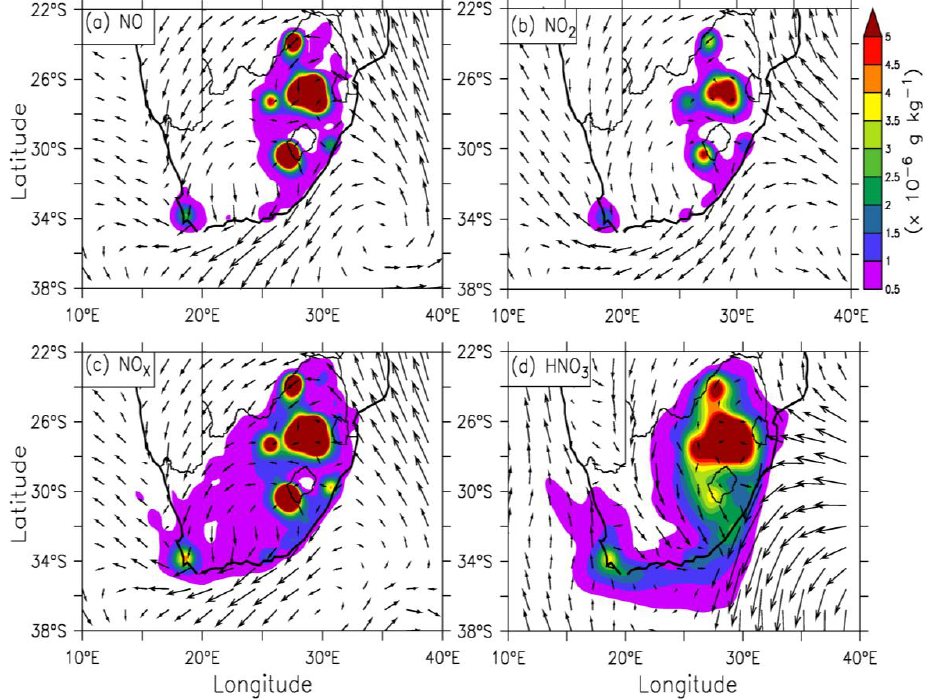
Figure 12: The composite of low-level (surface – 850 hPa) wind flow (arrow) during the extreme Fig. 12. The composite of low-level (surface–850hPa) wind flow (arrow) during the extreme pollution events in Cape Town. The correspond- ing pollutant concentrations (NO, NO 2 , NO x and HNO 3 ; × 10 − 6 gkg − 1 ) are shaded. pollution events in Cape Town. The corresponding pollutant concentration (NO, NO HNO3; x 10 -6 g kg -1 ) are shaded. fluxes for NO x (NO and NO 2 ) are negative, meaning accu- mulation of NO x (NO and NO 2 ) over the city, during the ex- treme